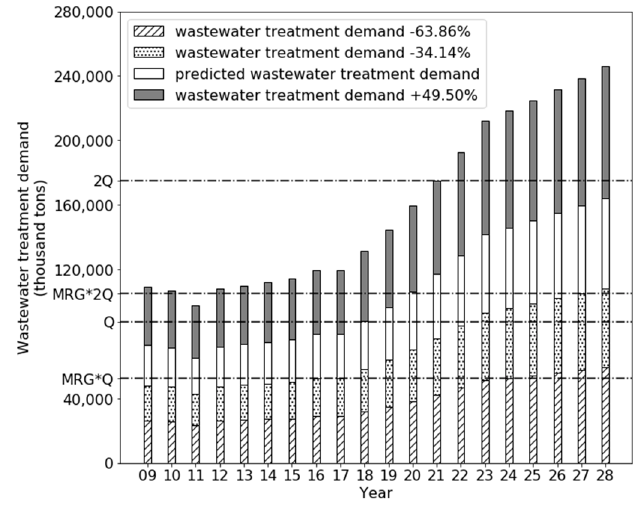
Figure 8. Demand fluctuation during the concession period.